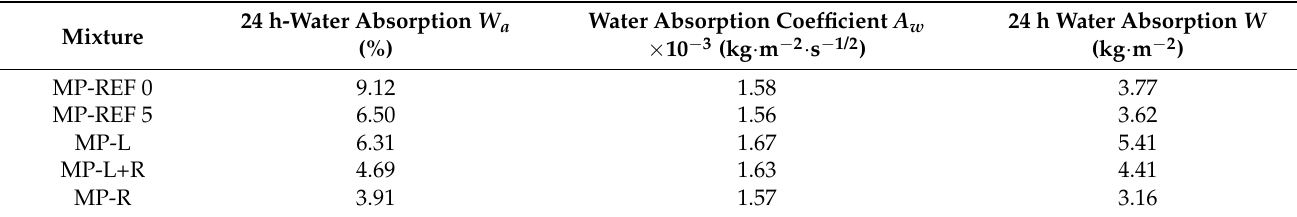
Table 10. Hygric parameters of the hardened